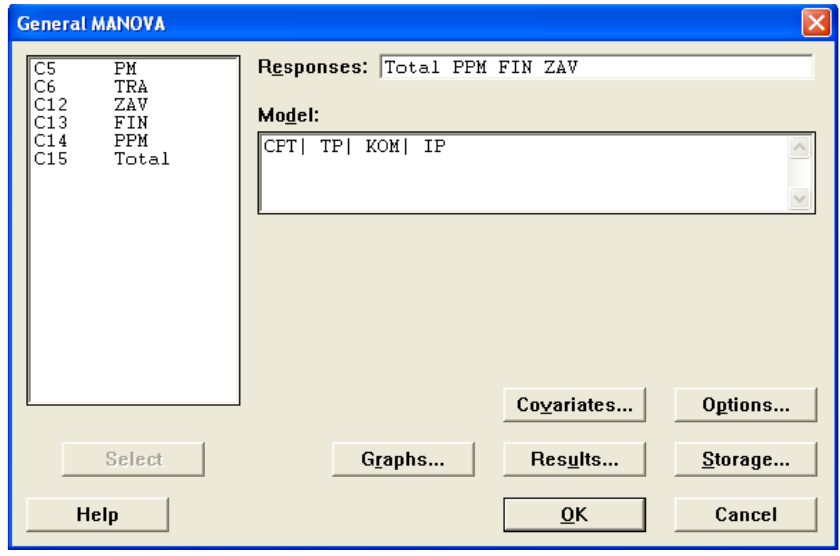
Fig. 6. Software Minitab MANOVA input